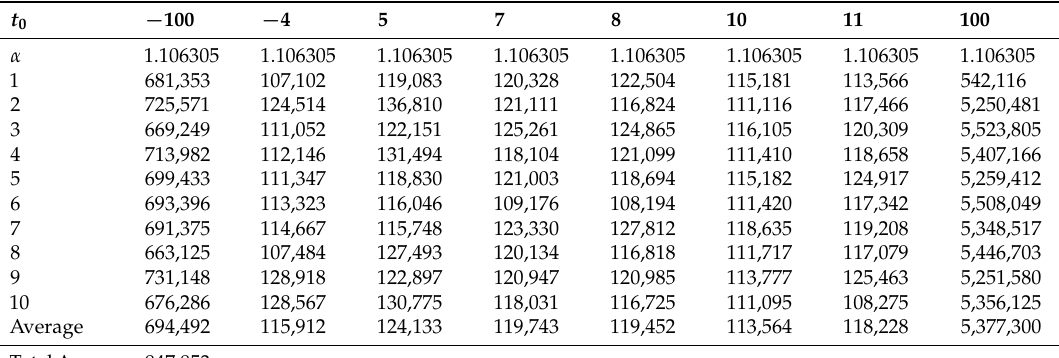
Table 10. Running time for different initial values of Example 4 by the Algorithm